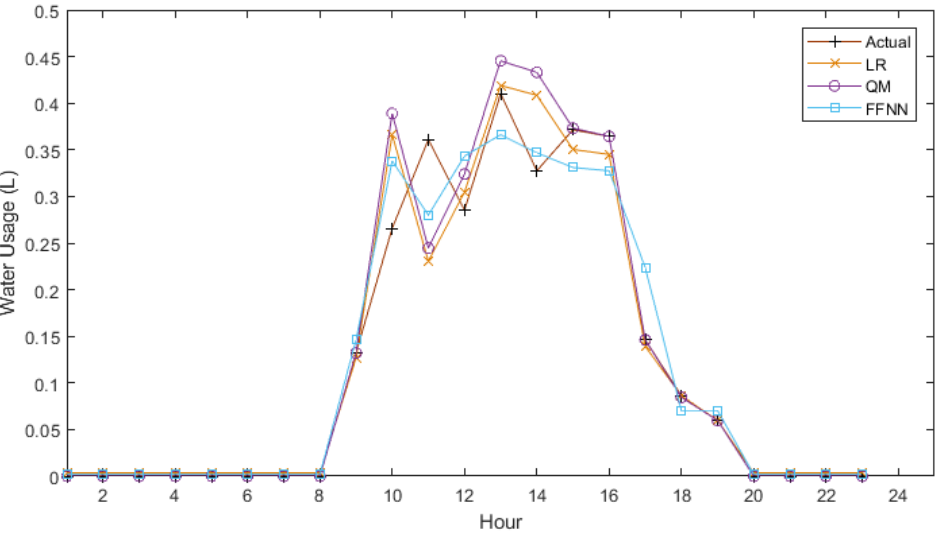
Figure 7. Day-ahead forecast for tomatoes using base model data.